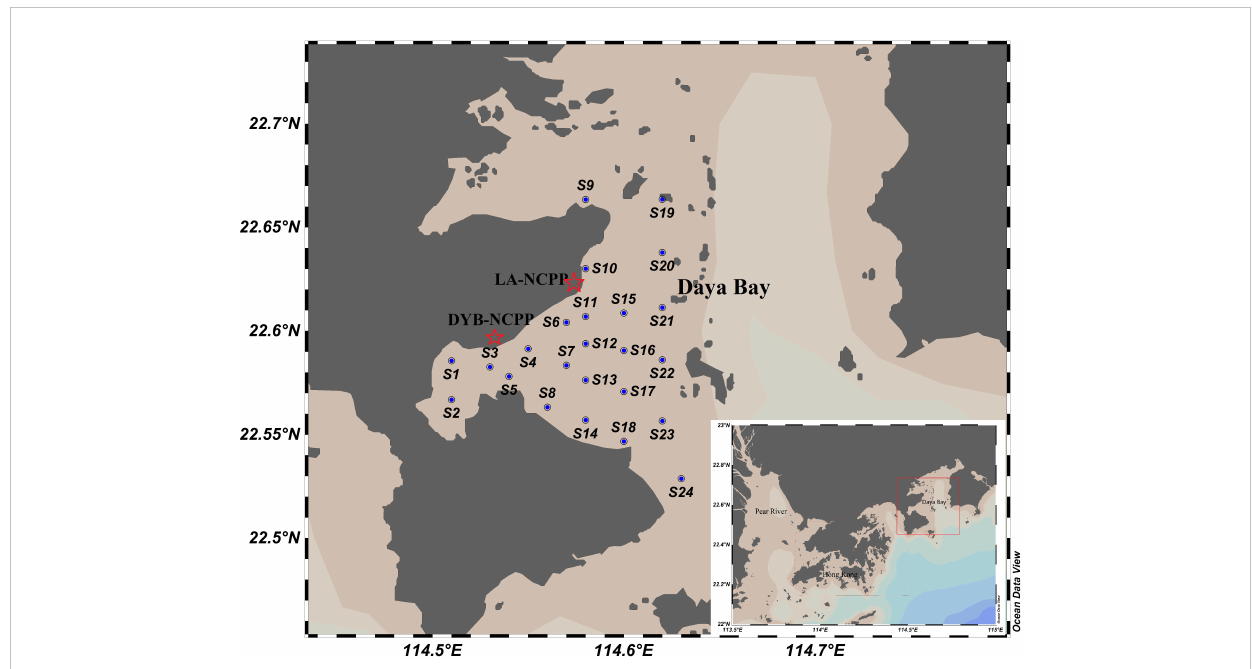
FIGURE 1 Study area and stations located at western Daya Bay. DYB-NCPP, Daya Bay Nuclear Power Plant; LA-NCPP, Ling ’ ao Nuclear Power